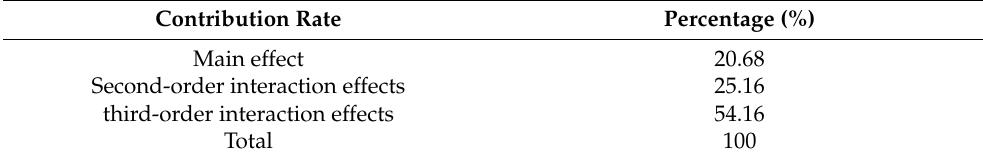
Table 6. The major effects of plastic additives on the total contribution rate of plastic biodegradability, as well as their